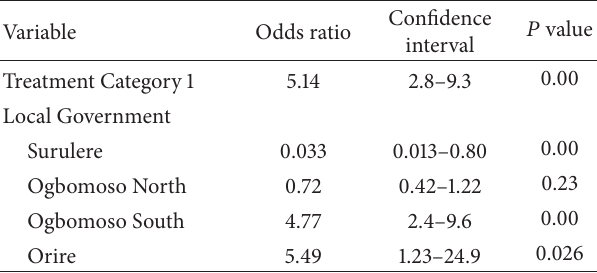
Table 4: Factors associated with favorable treatment